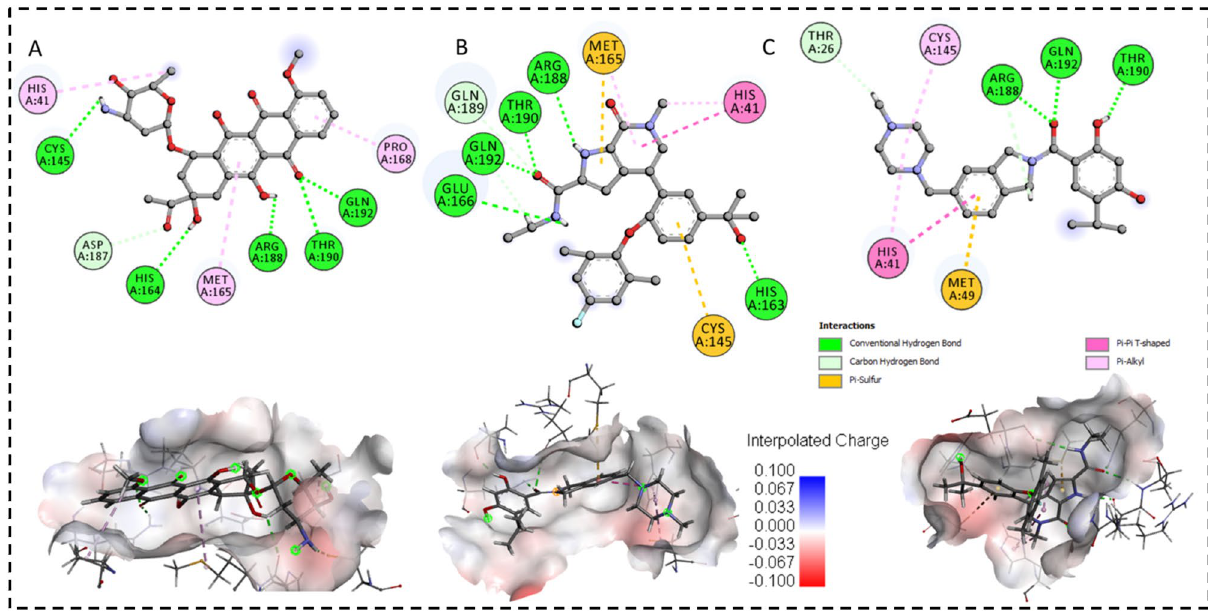
Figure 4. Docked poses of M pro enzyme with the proposed inhibitors. 2D plots and binding interactions of M pro enzyme with compounds ( A) Daunorubicin, (B) ABBV-744 and ( C) Onalespib. Lower panels are representing the surface view of conserved substrate-binding pocket of M pro in complexed with Daunorubicin, ABBV-744 and Onalespib, respectively (left to right).